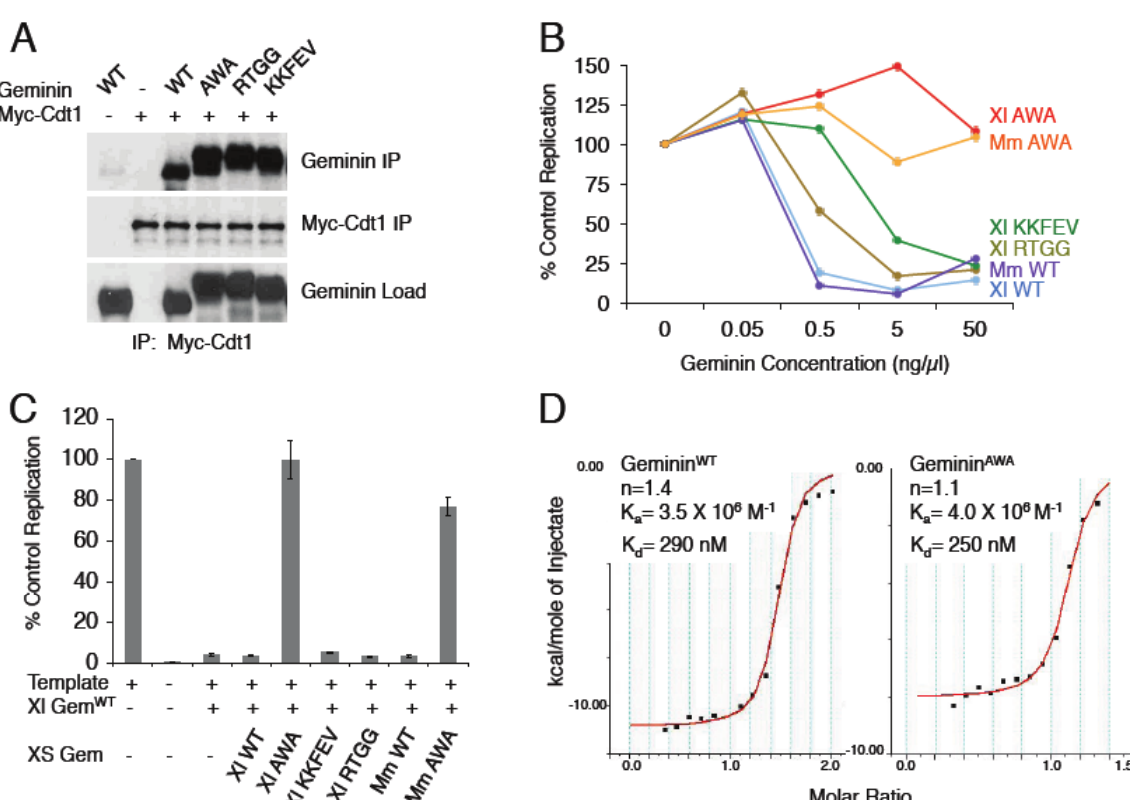
Figure 2. Defective Geminin mutants bind Cdt1. ( A ) Geminin missense mutants bind Cdt1. Recombinant Xenopus Geminin proteins were mixed with translated Myc-Cdt1. The reactions were precipitated with anti-Myc antibody, and the precipitate was blotted with the indicated antibodies. ( B ) Inhibition of DNA replication by Geminin mutants. Recombinant Geminin proteins were added to replication extracts made from Xenopus eggs at the indicated concentrations, and the extent of sperm DNA replication was measured.